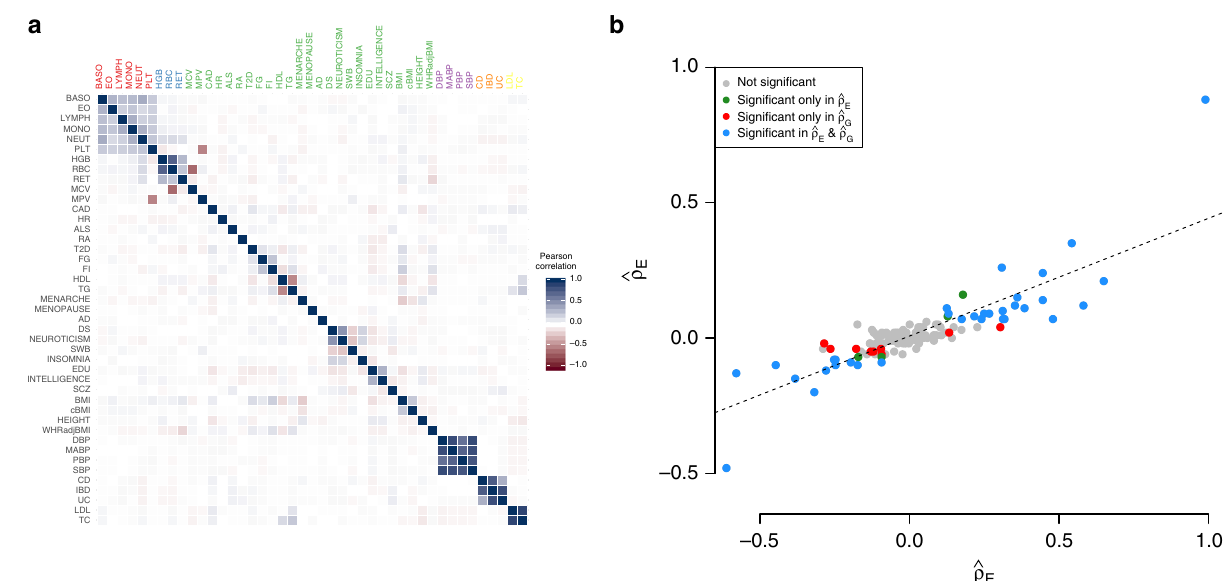
Fig. 4 Genetic trait correlation at the level of gene expression. a Expression correlation from TWMR results among 43 traits. For the 2974 independent genes and each pair of traits we calculated the Pearson ’ s correlation ( ^ ρ E ) between the Z scores (proportional to the standardized causal effects). Darker colors represent higher correlations, with blue and red corresponding to positive and negative associations, respectively. b Linear relationship between the expression correlation ( ^ ρ E ) and the genetic correlation ( ^ ρ G ) obtained from LD Score Regression. We selected the traits analyzed by our study and Bulik- Sullivan et al. 52 and for each pair of traits we compared the two correlations. Gray dots represent non-signi fi cant trait pairs, blue dots represent trait pairs signi fi cant for both correlation and red and green ones correspond to pairs of traits signi fi cant only in ( ^ ρ G ) or ( ^ ρ E ), respectively. The dotted line represents the regression line